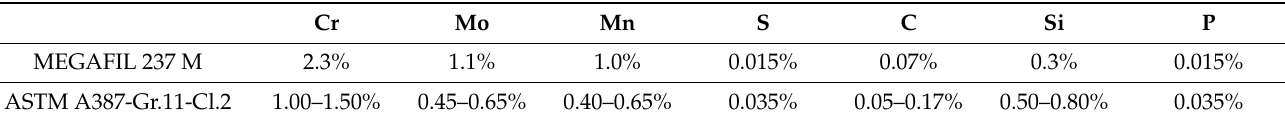
Table 1. The chemical substance of MCFW and ASTM A378-Gr.11-Cl.2 steel. Cr Mo